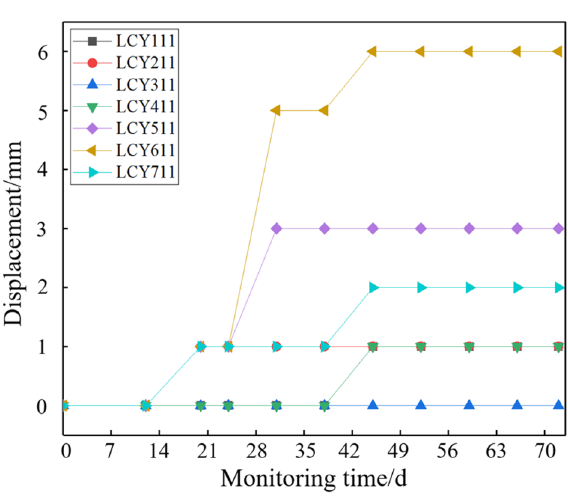
Figure 15. Observation results of roof layer separation